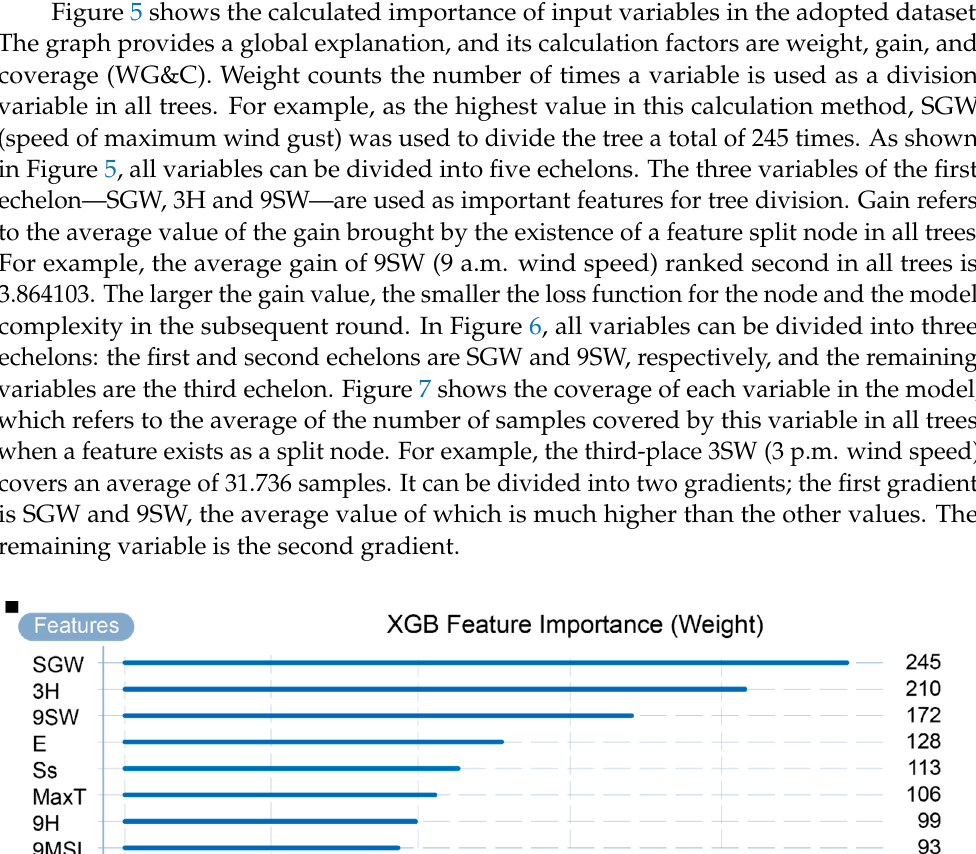
Figure 6. Feature importance by gain.